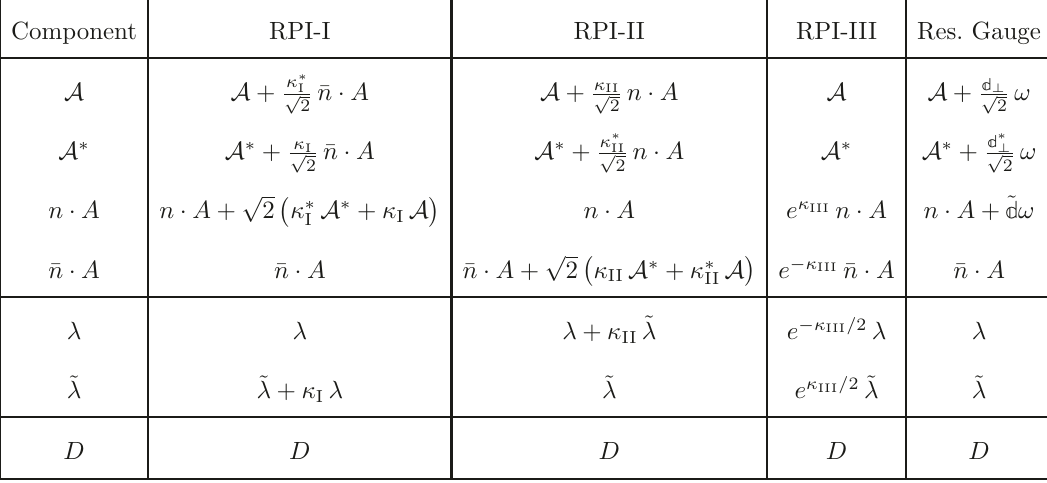
Table 4 . Transformation properties for the Abelian gauge theory degrees of freedom. Throughout, we work in LCG with ¯ n A = 0, such that and are RPI-I invariant. Like in the chiral matter · A A ∗ case, RPI-II is linearly realized with the inclusion of the ˜ λ and n A ·